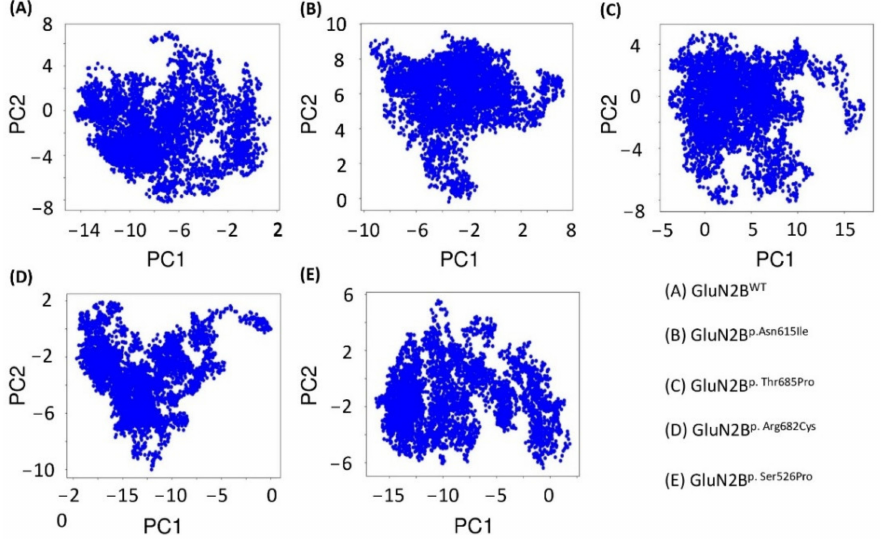
Figure 11. PCA of the native protein GluN2B WT ( A ) and four variants GluN2B p.Asn615Ile ( B ), GluN2B p.Thr685Pro ( C ), GluN2B p.Arg682Cys ( D ), and GluN2B p.Ser526Pro ( E